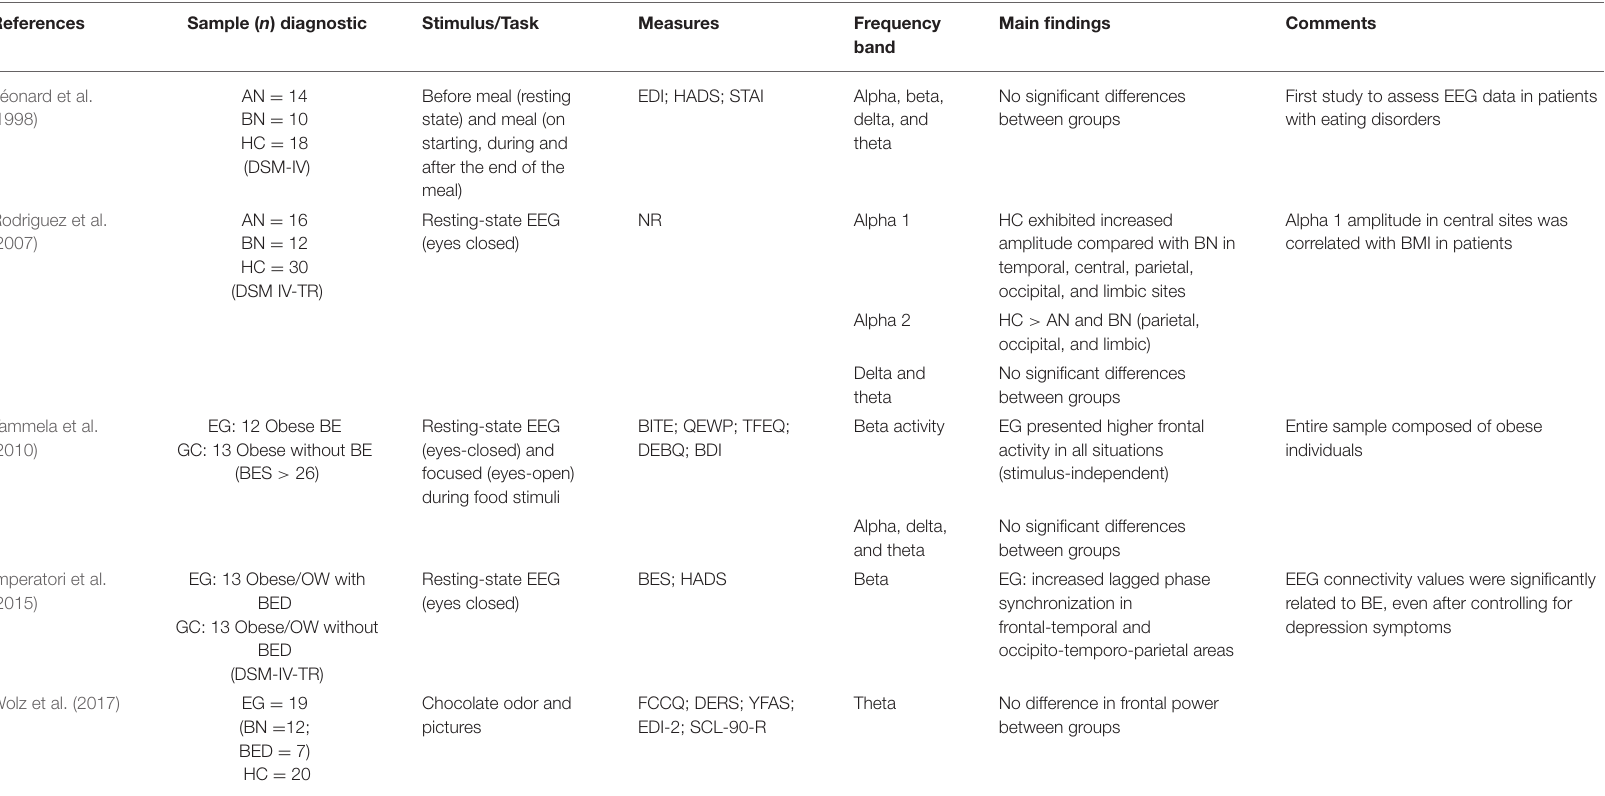
TABLE 4 | Frequency domain analysis: studies evaluating EEG oscillatory activity in